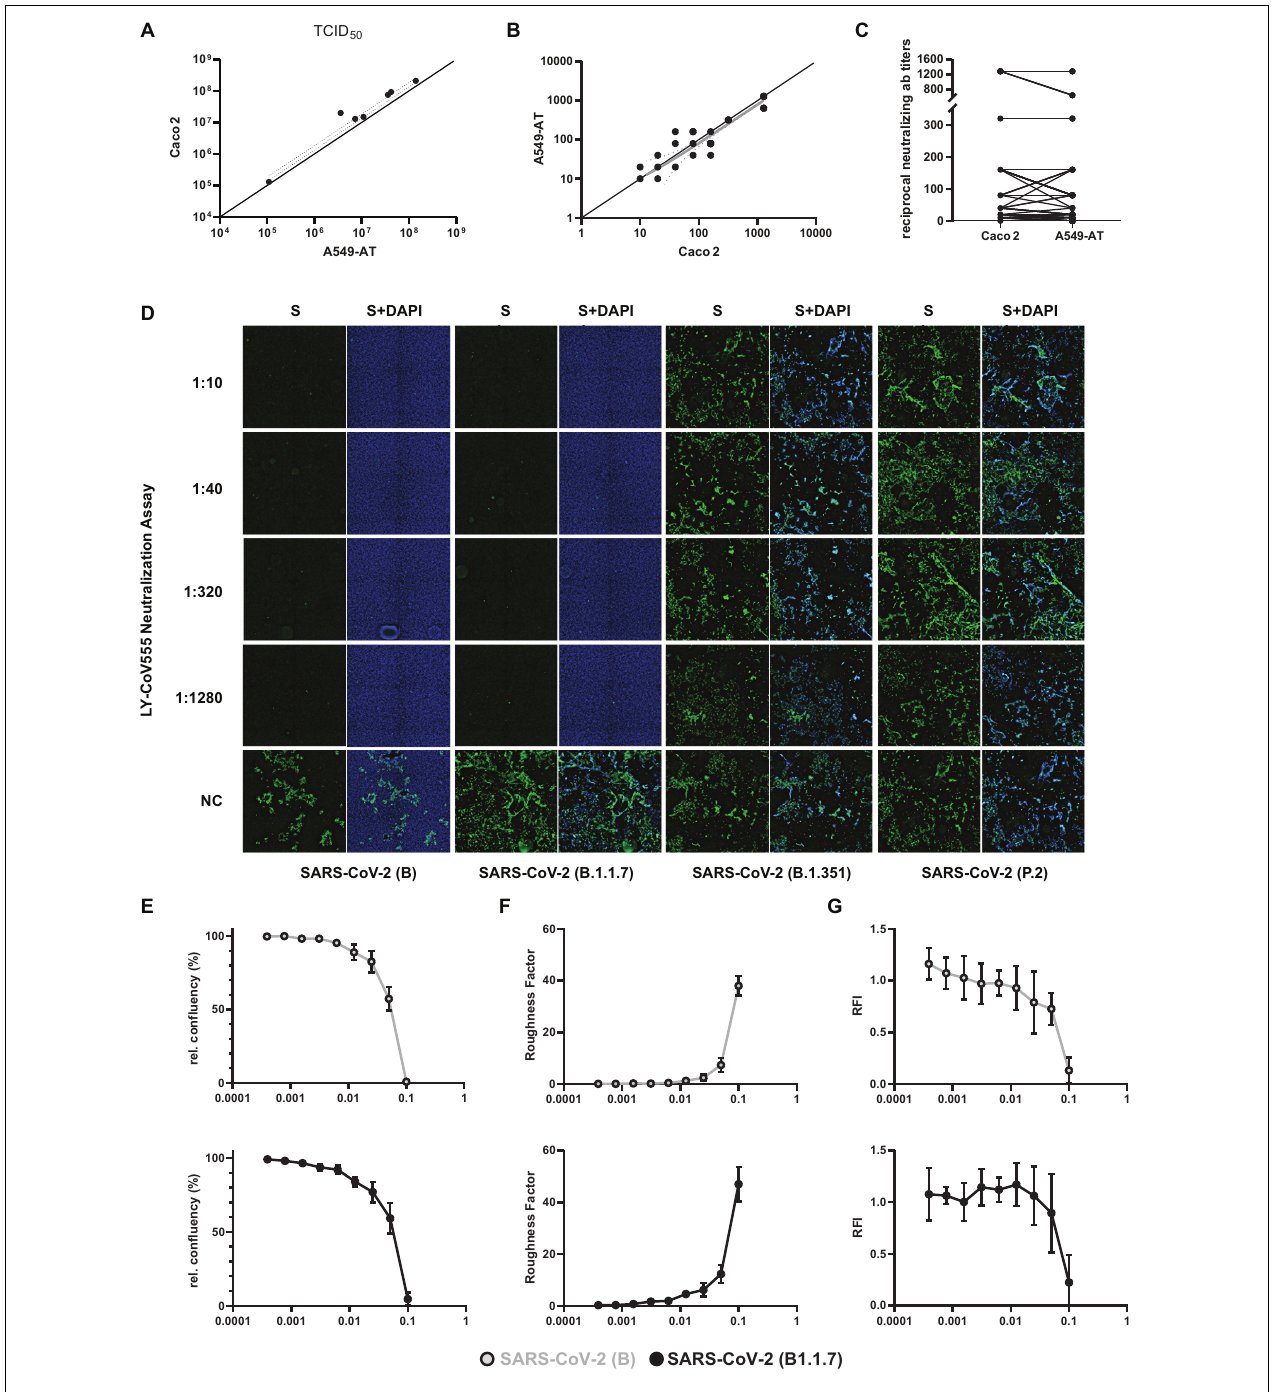
FIGURE 7 | Correlation of neutralization and TCID 50 test results obtained with A549-AT and CaCo2 cells. Representative results of two biological replicates confirmed in Caco2 cells are depicted. (A) Correlation of SARS-CoV-2 TCID 50 titers determined using A549-AT and Caco2 cells. (B,C) Reciprocal SARS-CoV-2 microneutralization titers resulting in 50% virus neutralization (NT 50 ). The values indicate mean values from two replicates per cell line. (D) Neutralization titers against SARS-CoV-2 variants B (FFM1), B.1.1.7, B.1.351, and P.2. The mAb solution containing bamlanivimab (LY-CoV555) was serially diluted (1:2) and incubated with 100 TCID 50 /well. Cells were inoculated and analyzed for a CPE formation after 72 h. Immunofluorescence staining was performed using spike antibody and a secondary antibody coupled to Alexa488 for detection. DAPI was used to stain nuclei. (E) Relative confluency and (F) roughness of SARS-CoV-2 B and B.1.1.7 infected A549-AT cells were measured as surrogate marker to monitor for SARS-CoV-2 induced CPE formation at the indicated timepoints. (G) Normalized mean of relative fluorescence intensity (RFI) measured at five spots per well. Error bars indicate standard deviation from at least three biological replicates.